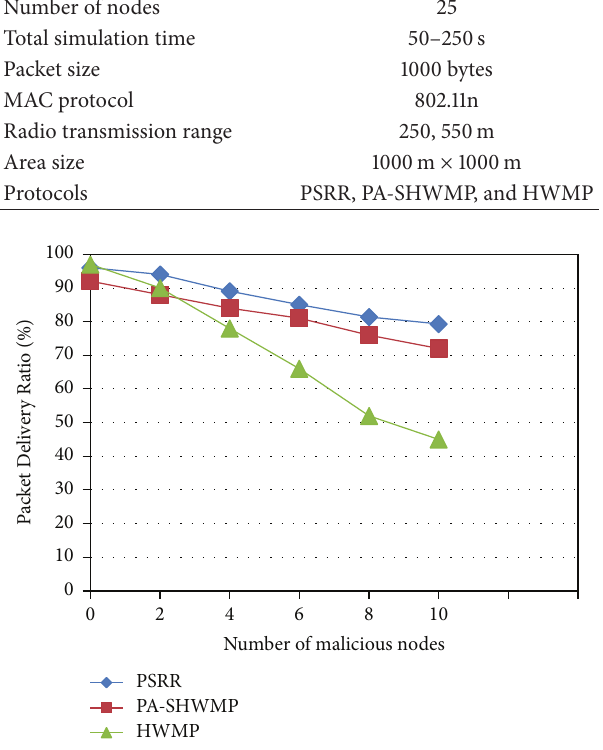
Figure 2: Packet Delivery Ratio versus number of malicious